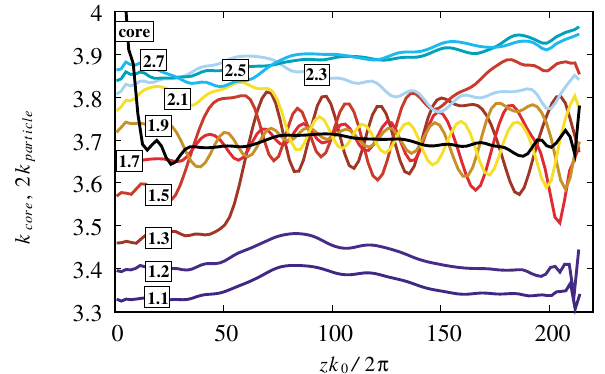
FIG. 9. (Color) Wave numbers for core and single particle oscillations. Single particle wave numbers are multiplied by 2 and depict particles starting with different initial radii (1.1–2.7 times the matched core radius), (cid:18) (cid:3) 0 : 8 , rms error amplitude: